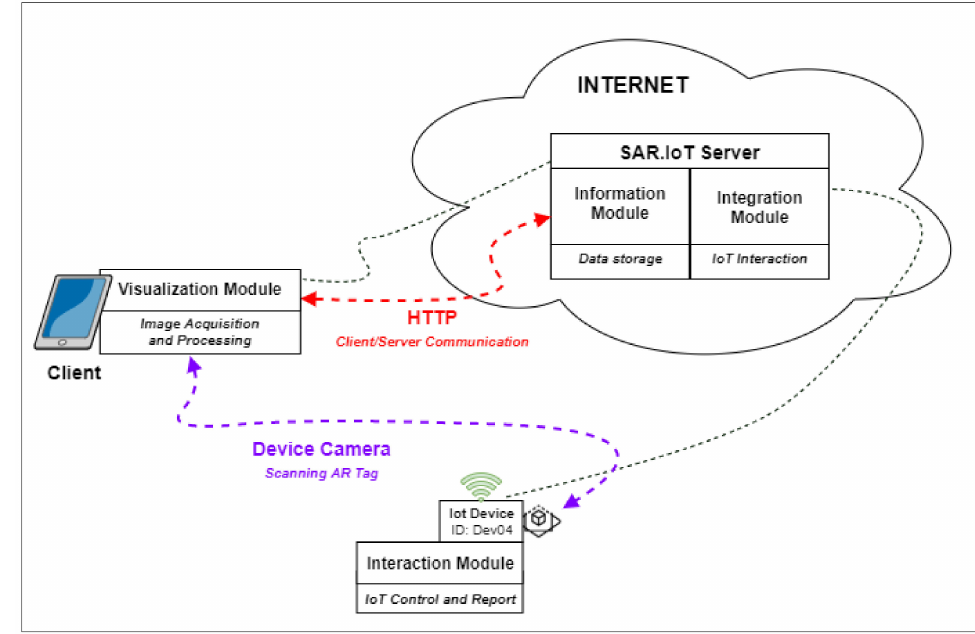
Figure 2. Client